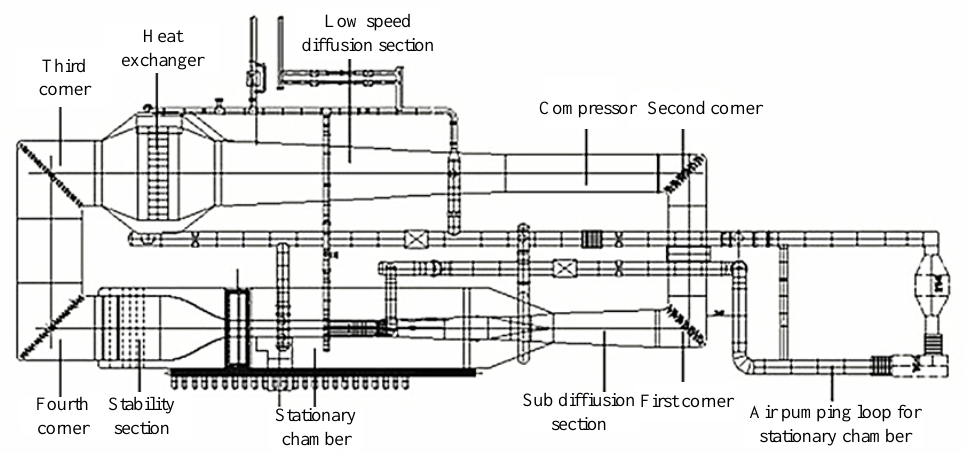
Figure 2. Structure of the wind tunnel system.